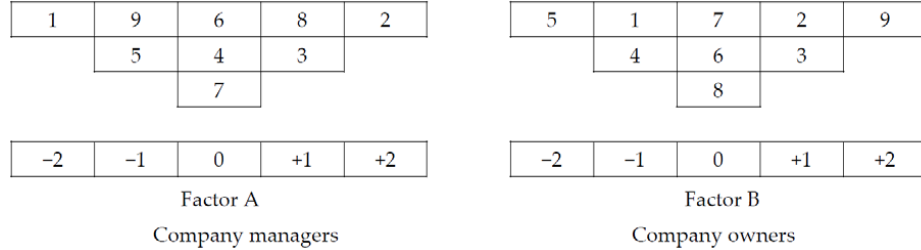
Figure 2. Q ‐ grids of differences in statements of company managers and owners. Figure 2. Q-grids of differences in statements of company managers and